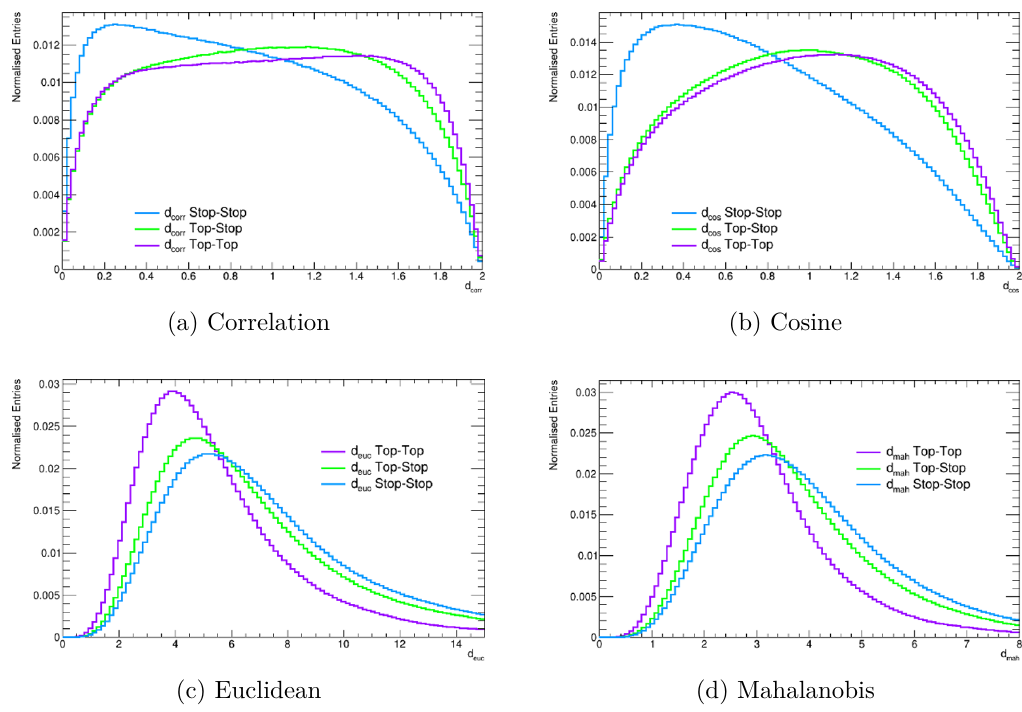
Figure 8. Distributions of the distance metrics we use in our prototype stop search, calculated using inclusive samples for